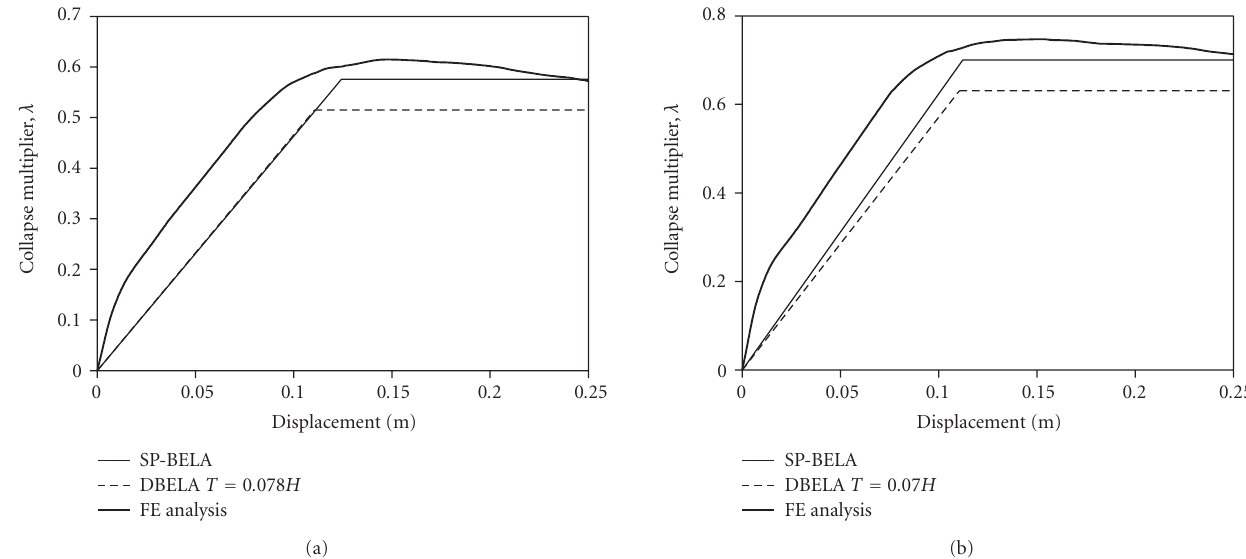
Figure 7: Comparison of pushover analyses for seismically designed building (a) c = 10% (b) c = 12 .